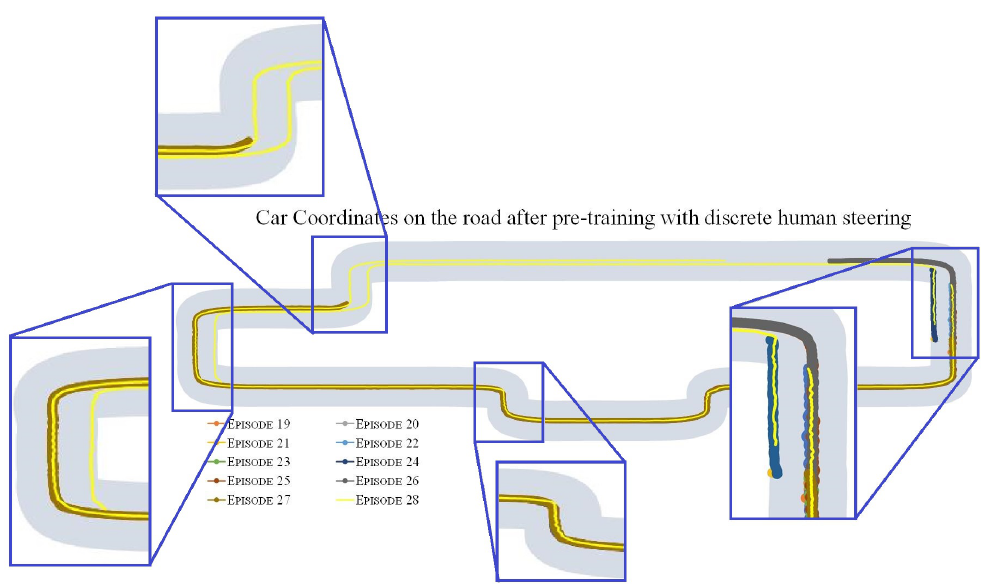
Figure 9. SAC + Discrete Steering Feedback: the car’s trajectory on the roadway after pre-training the SAC by 5000 steps of discrete human steer feedback. Four zoomed-in overlays show the details of some busy parts of the road.